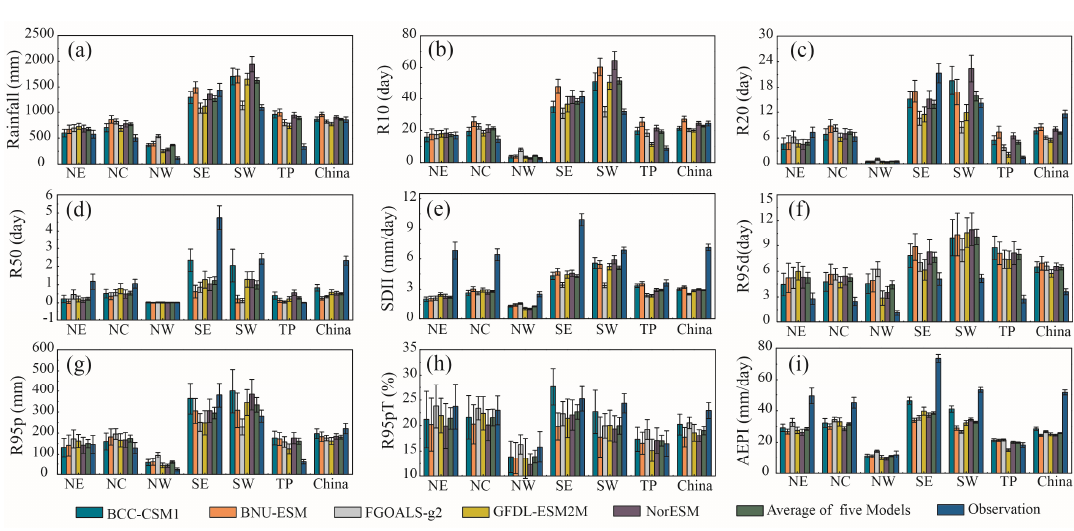
Figure A2. Averages of EPIs in China calculated from five CMIP5 models, average of the five models and the observations from 1960 to 2005: ( a ) annual average rainfall, ( b ) annual average R10, ( c ) annual